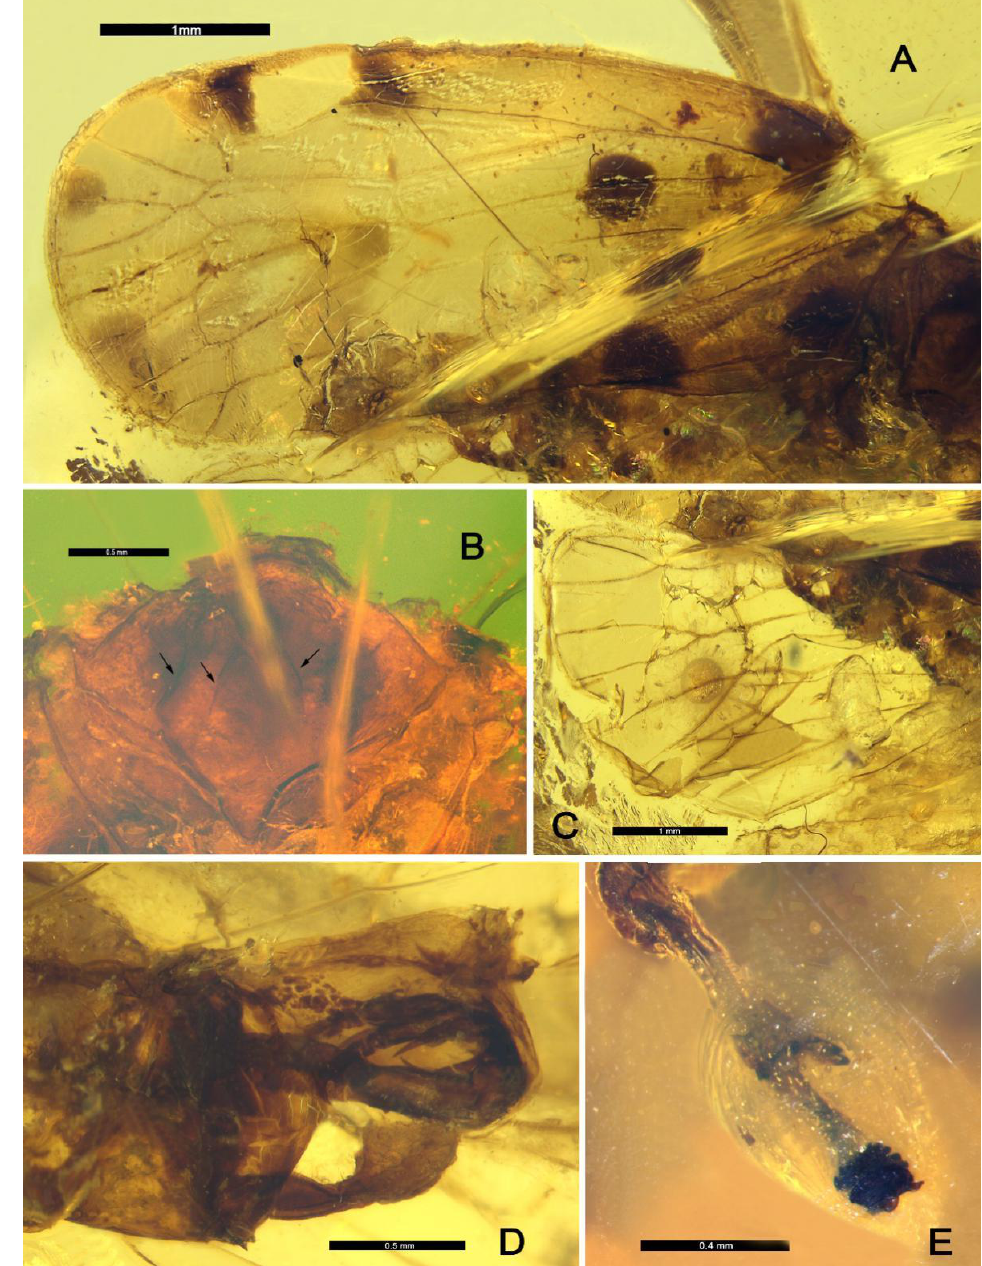
Figure 2. Maculixius jiewenae sp. nov. , Holotype, MDHP11. ( A ) Left forewing, dorsal view. ( B ) Mesonotum, dorsal view. ( C ) Hindwing, dorsal view. ( D ) Male terminalia, lateral view. ( E ) Apex of tibia and tarsus on left leg, ventral view. The arrows indicate the visible carinae.